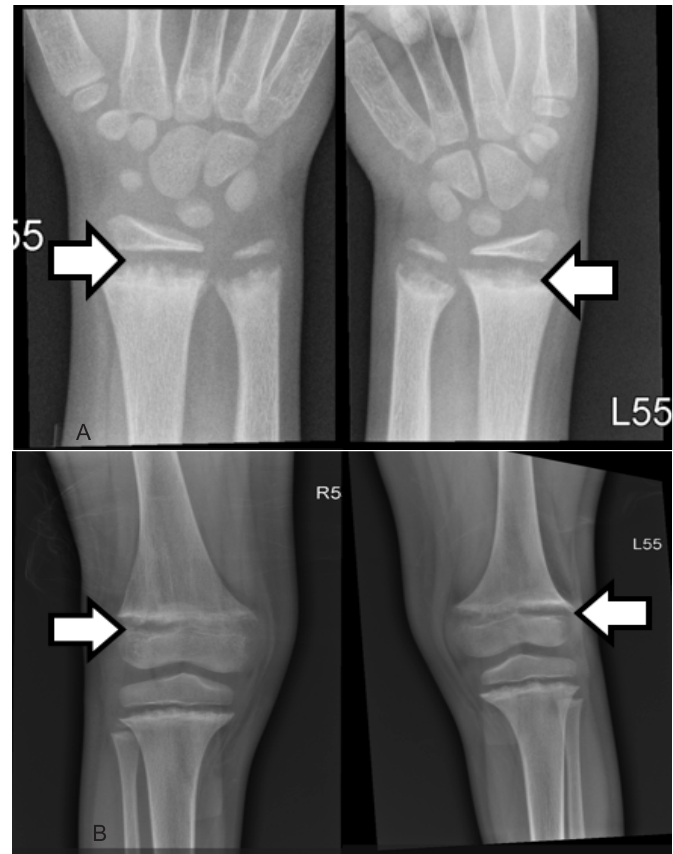
Image 3. Radiograph of bilateral wrists (A) and knees (B) of an eight-year-old boy with new-onset seizure. Arrows denote areas of poor bone